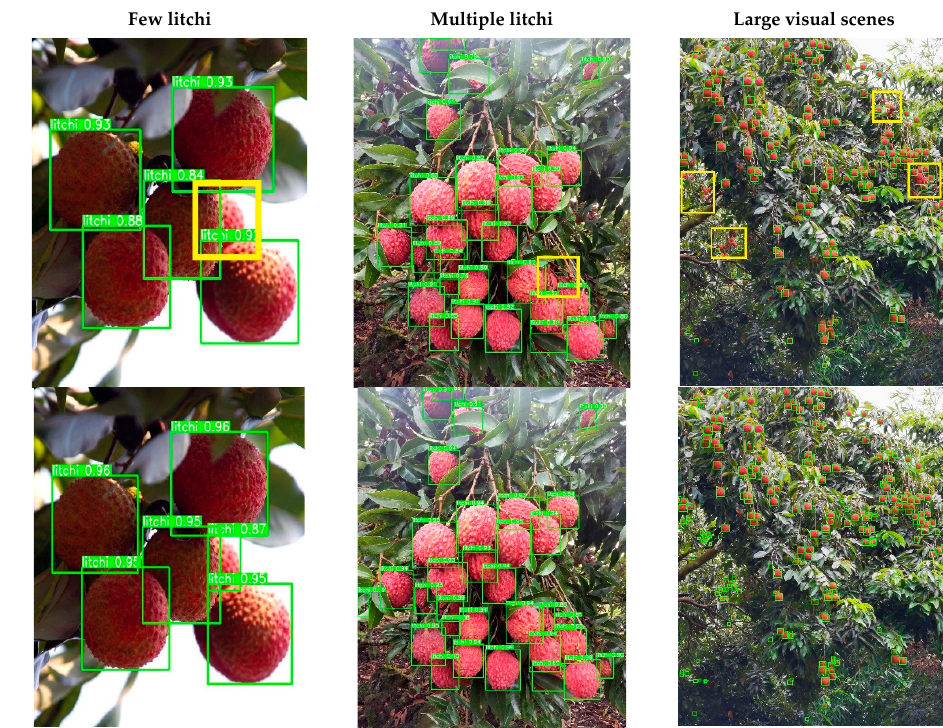
Figure 10. The detection effects of different amounts of litchis before and after improvement.